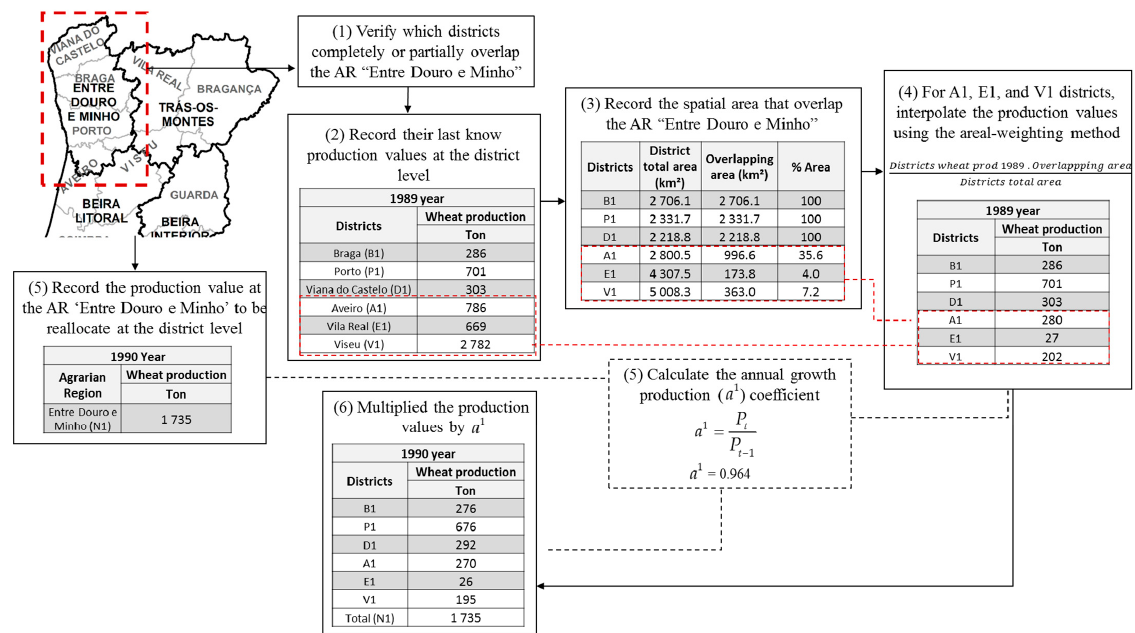
Figure 4. Conceptual diagram of wheat production values interpolation (1990) from the AR “Entre Douro e Minho” to the district level.